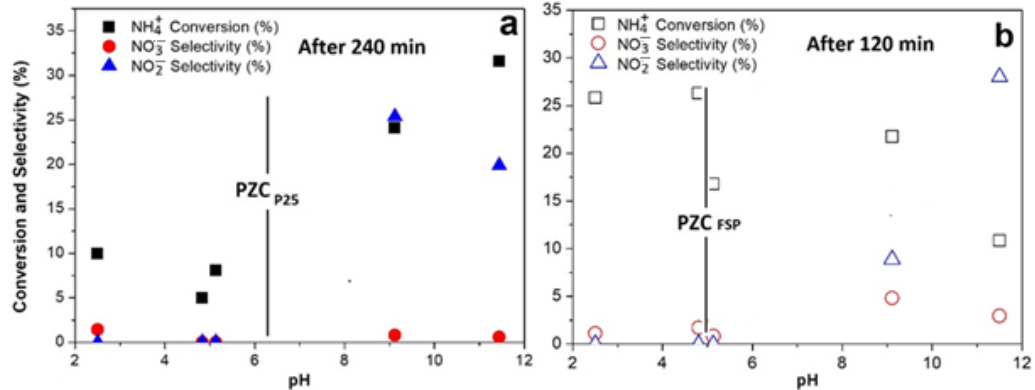
Figure 4. Conversion of NH 4 + /NH 3 and NO 2 − and NO 3 − selectivity vs. pH considering the sample ( a ) after 240 min of reaction for P25 (solid colored symbols); ( b ) after 120 min for FSP (hollow symbols). Conversion and selectivity (%) figures on y-axis of diagrams ( a , b ).